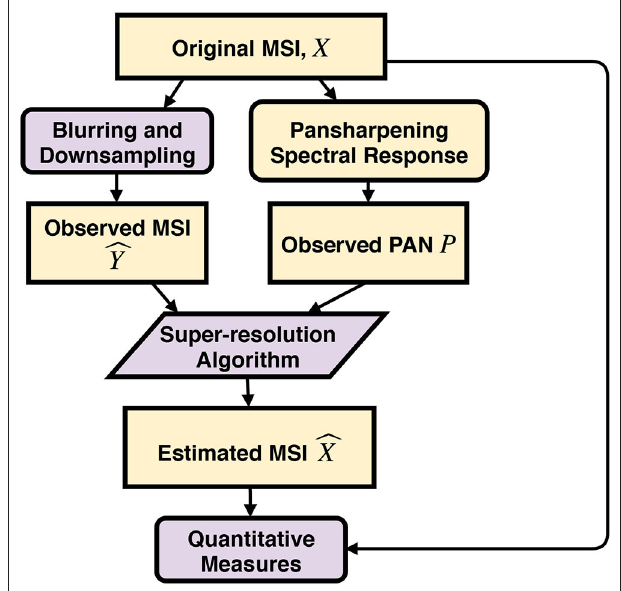
FIGURE 3 | Flow diagram of the experimental procedure for synthetic